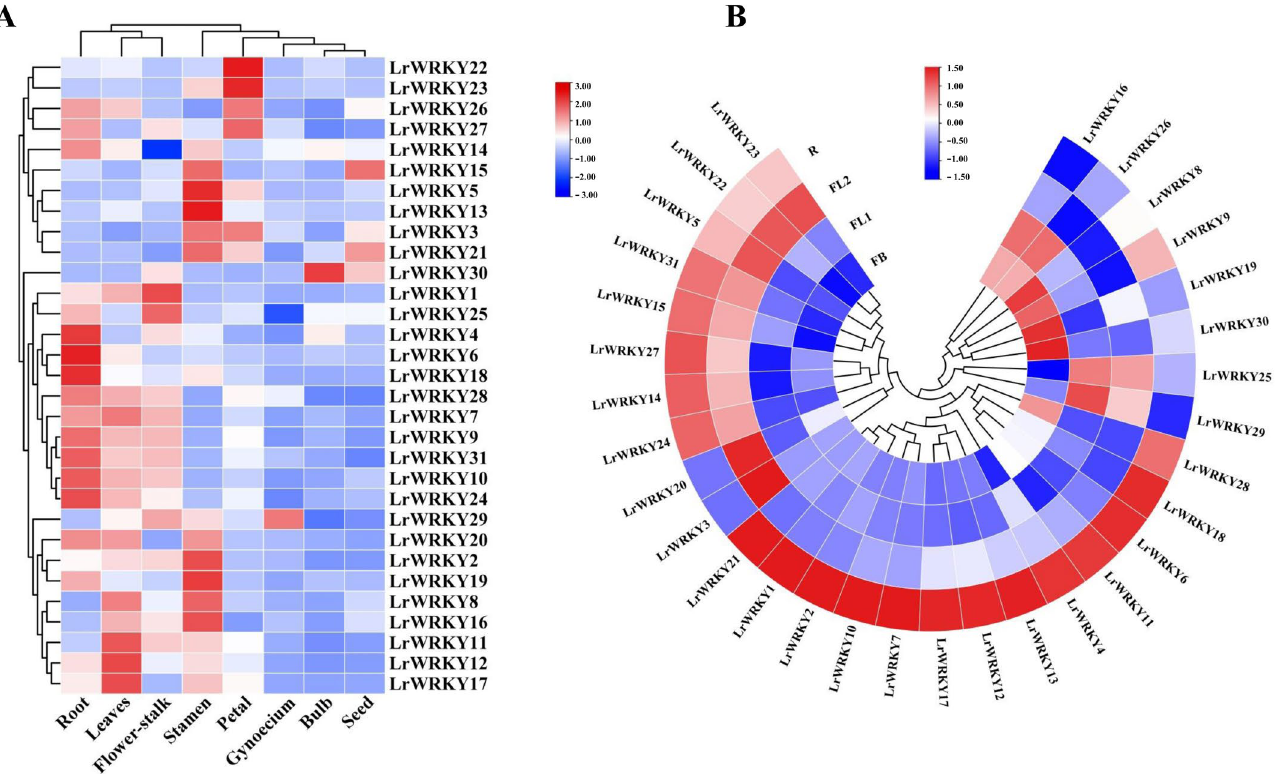
Figure 5. LrWRKY gene expression patterns in various L. radiata tissues. ( A ) Expression profile heatmap with hierarchal clustering of LrWRKYs in different tissues of L. radiata . ( B ) Expression profile heatmap with hierarchal clustering of LrWRKYs at different flower developmental stages of L. radiata . The relative expression for each gene is depicted by color intensity in each field. Higher values are represented by red, whereas lower values are represented by blue. FB, flower—bud differentiation stage; FL1, partially opening flower stage; FL2, fully opened flower stage; R, senescent flower stage.